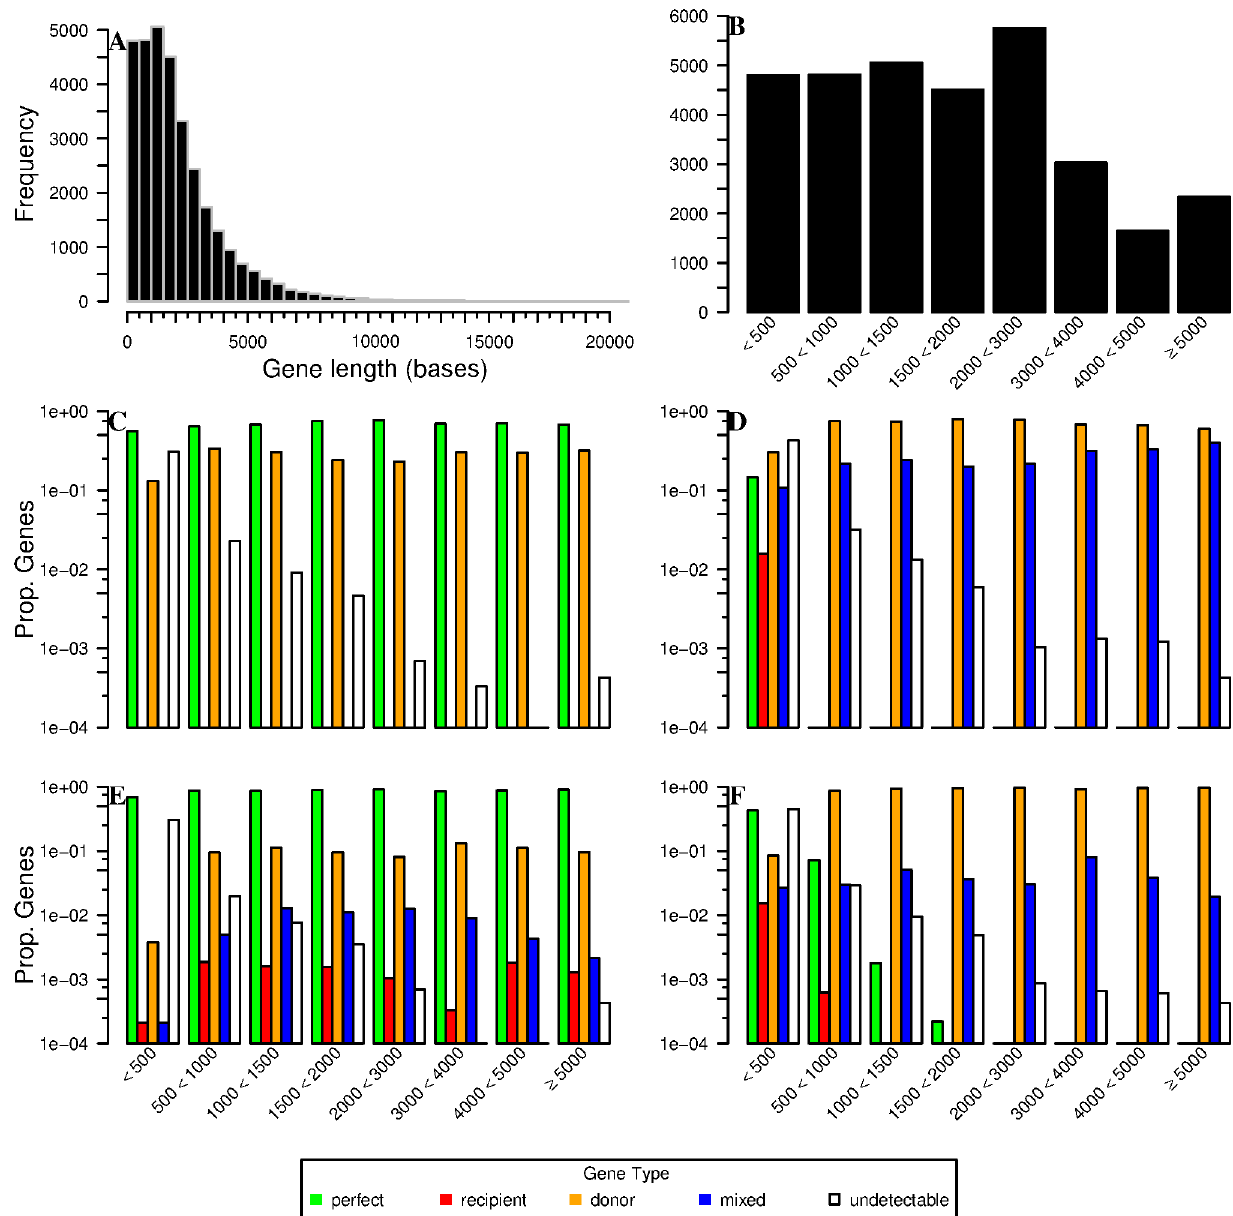
Fig 3. Proportion of gene types recoveredin divergent simulations by size-class of gene. (A) Histogram of genelengths for the Danio rerio transcriptome used for simulatingRNA-seq reads. (B) Number of genes from A, by size-class in subsequent windows. 100 base reads are plotted with 0% divergence (C) and 30% divergence (D); 350 base reads with 0% divergence (E) and 30% divergence(F). Gene types are describedin the